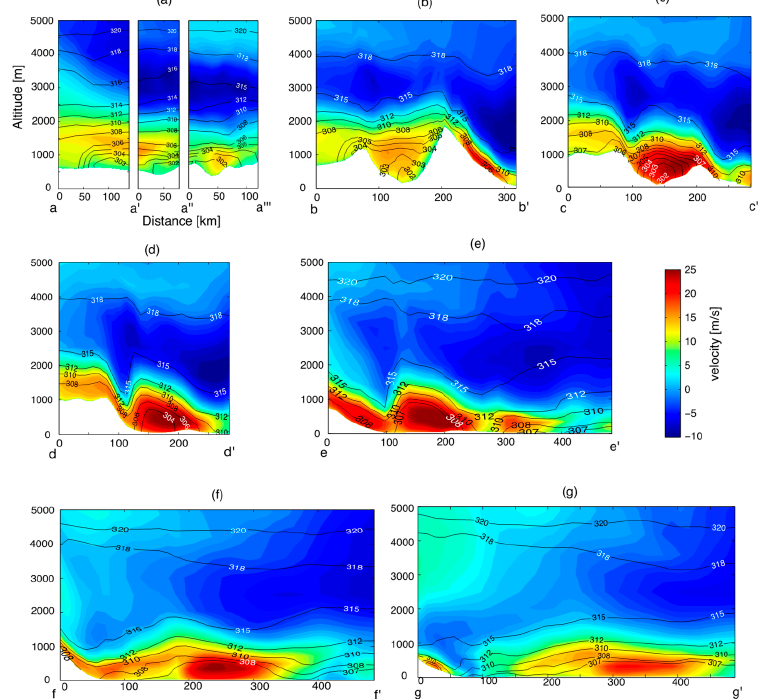
Figure 7. Cross sections of normal velocity and potential temperature, beginning upstream and proceeding down through the Tokar Gap and out over the Red Sea. The viewer faces downstream (roughly NNE). The data are plotted at 05 UTC (8 a.m. local time) on 12 July 2008. Section locations are shown in Figure 1.